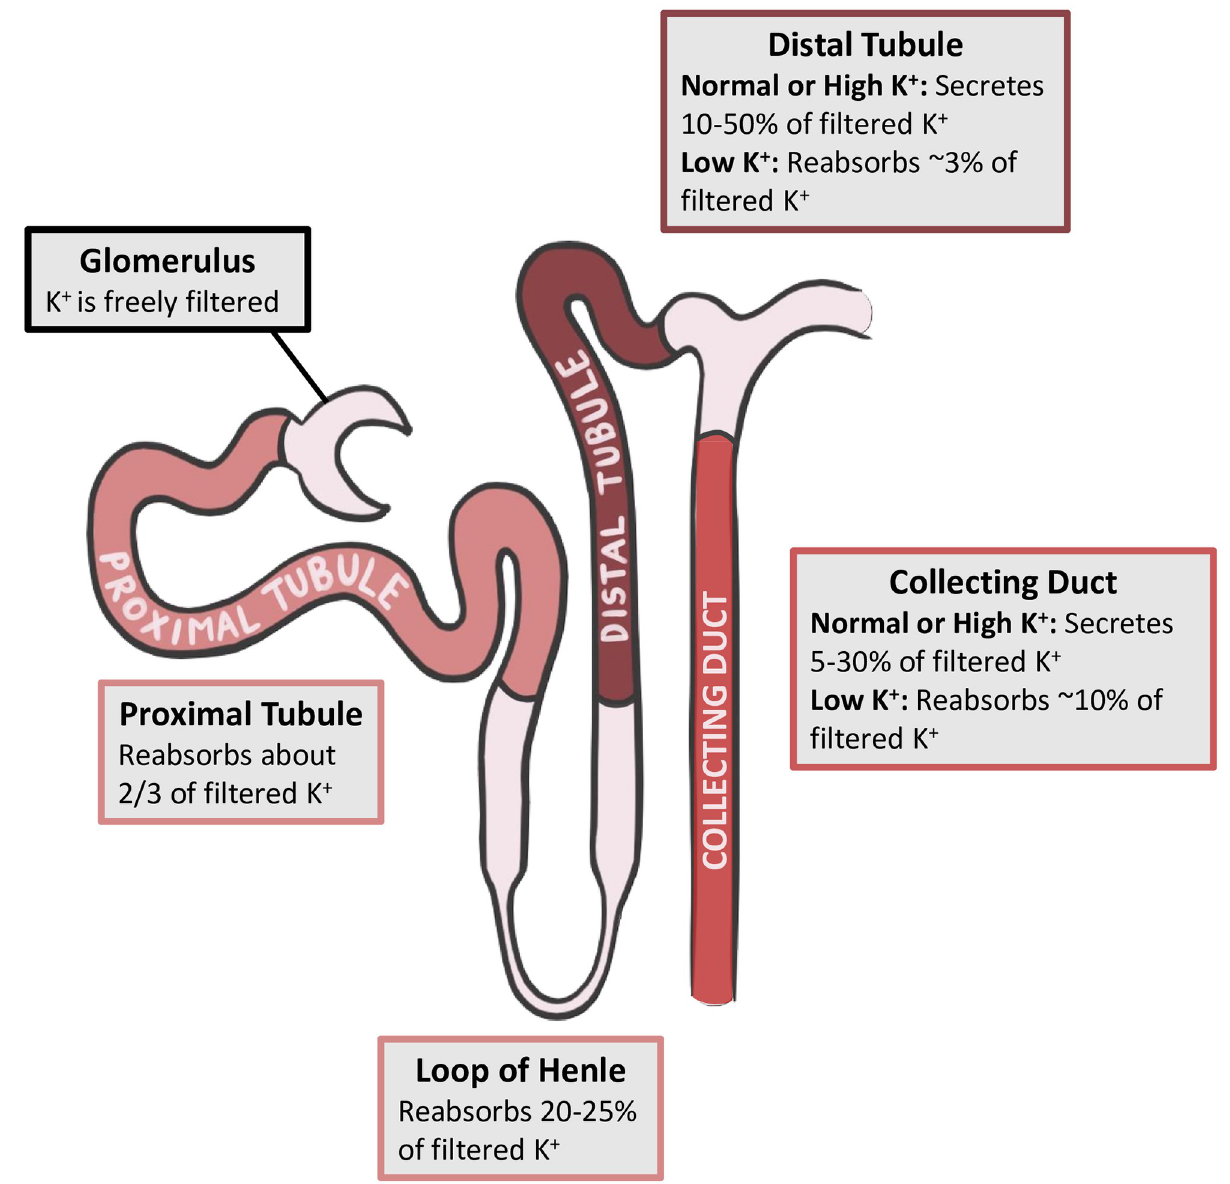
Fig 1. Renal handling of K + . Transport of K + in key nephron segments during normal, low, and high K + intake.